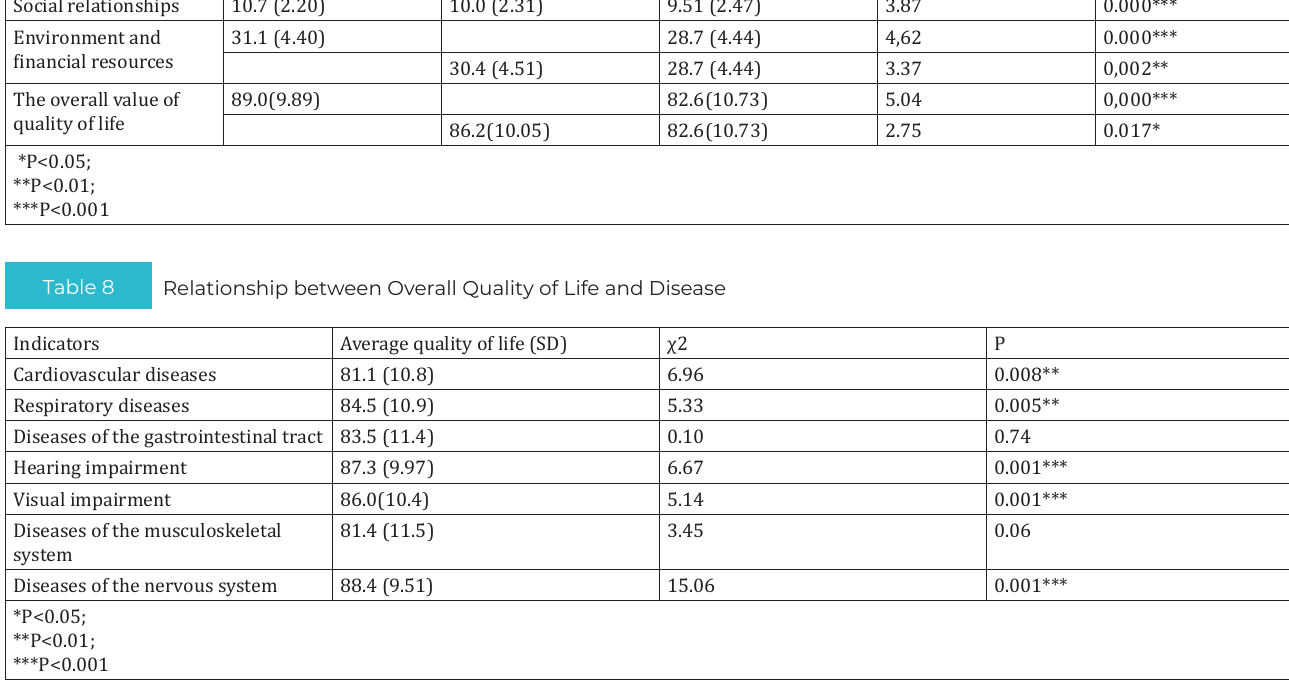
Quality of life metrics by domain